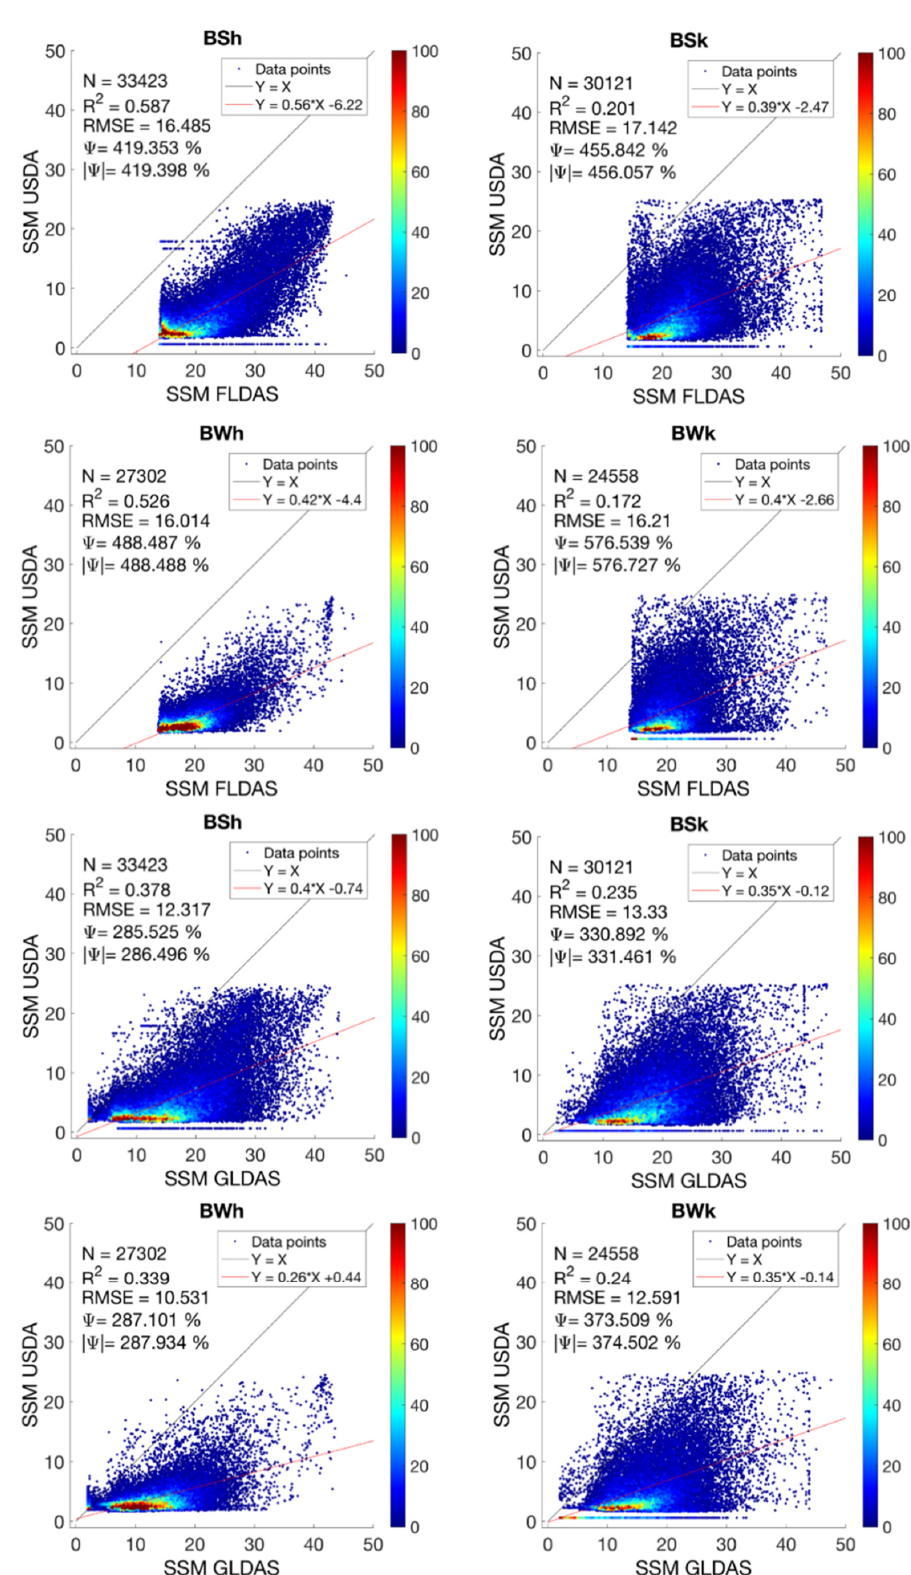
Figure 10. Comparisons of NASA-USDA SSM versus SSM values obtained from FLDAS and GLDAS for all types of arid regions. The solid black and red lines represent the one to one line and regression line, respectively.